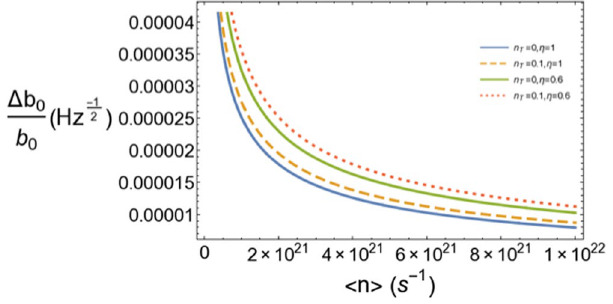
Figure 4. Figure of merit of the sensitivity of our scheme vs. average number of photons per second in the presence of optical losses and initial mixedness for λ = 10 3 nm, r 1 / b 0 = 10 7 , r 1 / L = 10 5 and L = 10 6 m. We see that the combined effect of optical loss and mixedness has a moderate impact on the